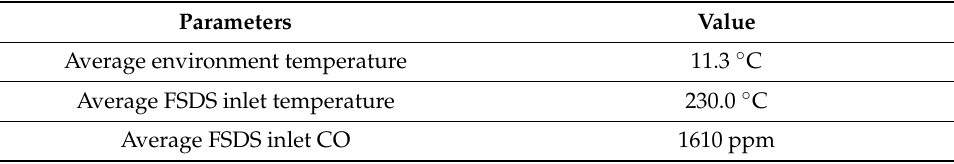
Table 5. List of the measured fire environment